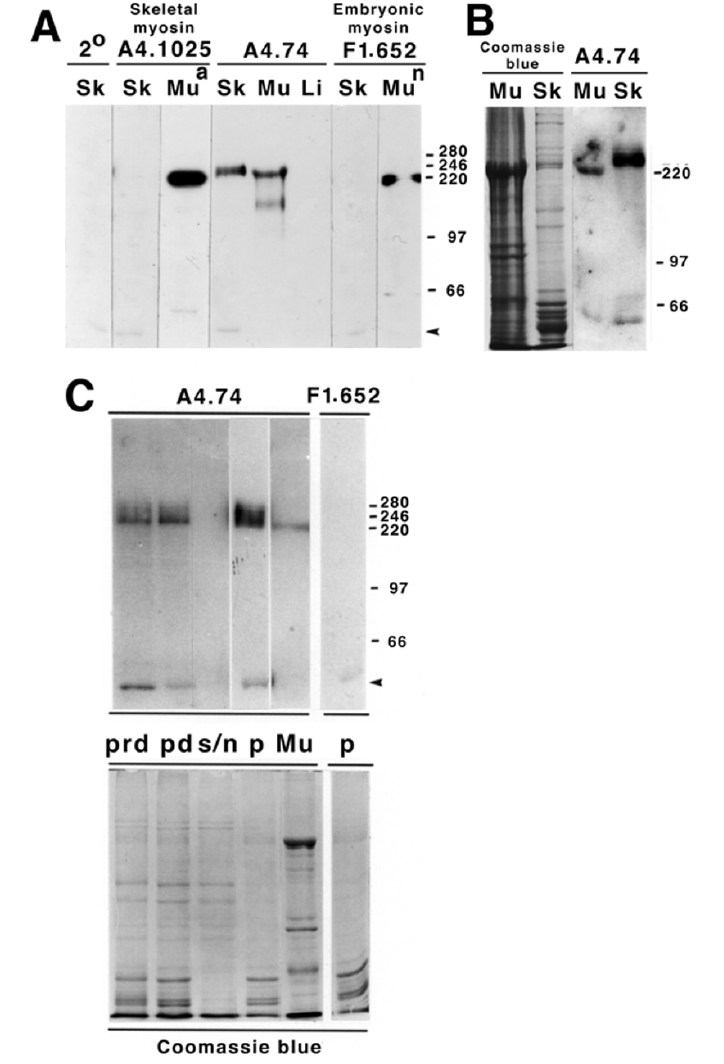
Figure 7 Skin A4.74-antigen is distinct from fast skeletal myosin IIA and co-purifies with keratin. A. Western analysis of P9 rat tail skin proteins (Sk) shows that proteins around M 230000 are detected by A4.74, but not by F1.652 or A4.1025. A4.74 detects a r protein of M 220000 typical of skeletal muscle MyHC fast IIA in samples of P29 rat extensor digitorum longus (edl) muscle r (Mu) but no proteins in P7 liver (Li). A similar M 220000 band was detected with anti-embryonic skeletal myosin antibody r F1.652 in neonatal P7 lower hindlimb muscle (Mu n ) and with the general anti-sarcomeric myosin antibody A4.1025 in P35 lower hindlimb muscle (Mu a ). The faint M ~45 000 band (arrowhead) in the skin sample is a non-specific cross-reaction, as the r control secondary antibody alone detects this band (2°). Comparable total protein (~50 µ g) was loaded per lane and checked by Coomassie stain of a duplicate gel. B. The A4.74-antigen in skin (Sk) was more readily detected than fast IIA MyHC in P29 edl (Mu) muscle in Western blots, even when more muscle protein was loaded as indicated with Coomassie blue staining in identical lanes. C. When skin is dissociated in 6 M urea, the A4.74-reactive proteins (upper panel) are fully dissolved and iso- (bands below M 66000, lower panel, Coomassie blue stain of a replicate gel). In this experiment, absolute loaded protein was r stain. After dialysis into PBS to remove urea, no protein or antigenic reactivity is lost (pd). Upon re-centrifugation, all detecta- ble A4.74-reactive protein is found in the pellet (p) associated with keratins, whereas many other proteins remain in the super- natant (s/n). Control antibody F1.652 demonstrates the non-specificity of the low M band (arrowhead), but shows no r reactivity to A4.74-antigen, whereas A4.74 detects the M 220000 skeletal IIA fast MyHC in P29 edl muscle extract (Mu). Each r skin lane contains an equivalent proportion of the original